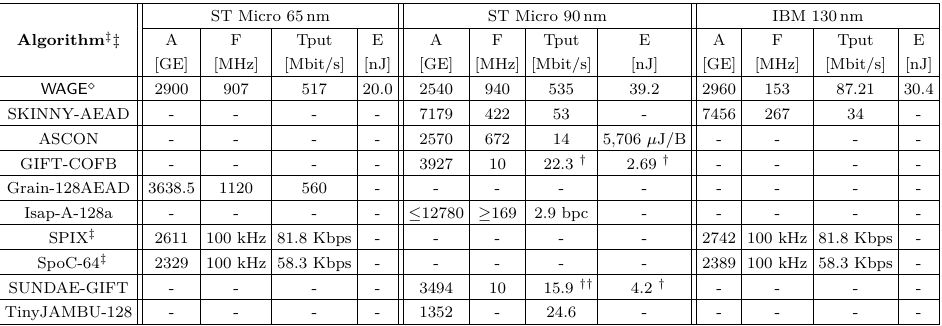
Table 1: Comparison of the different ASIC implementation results of WAGE with other NIST LWC round 2 candidates. Tput, A, F, and E denote throughput, area, maximum frequency, and energy,